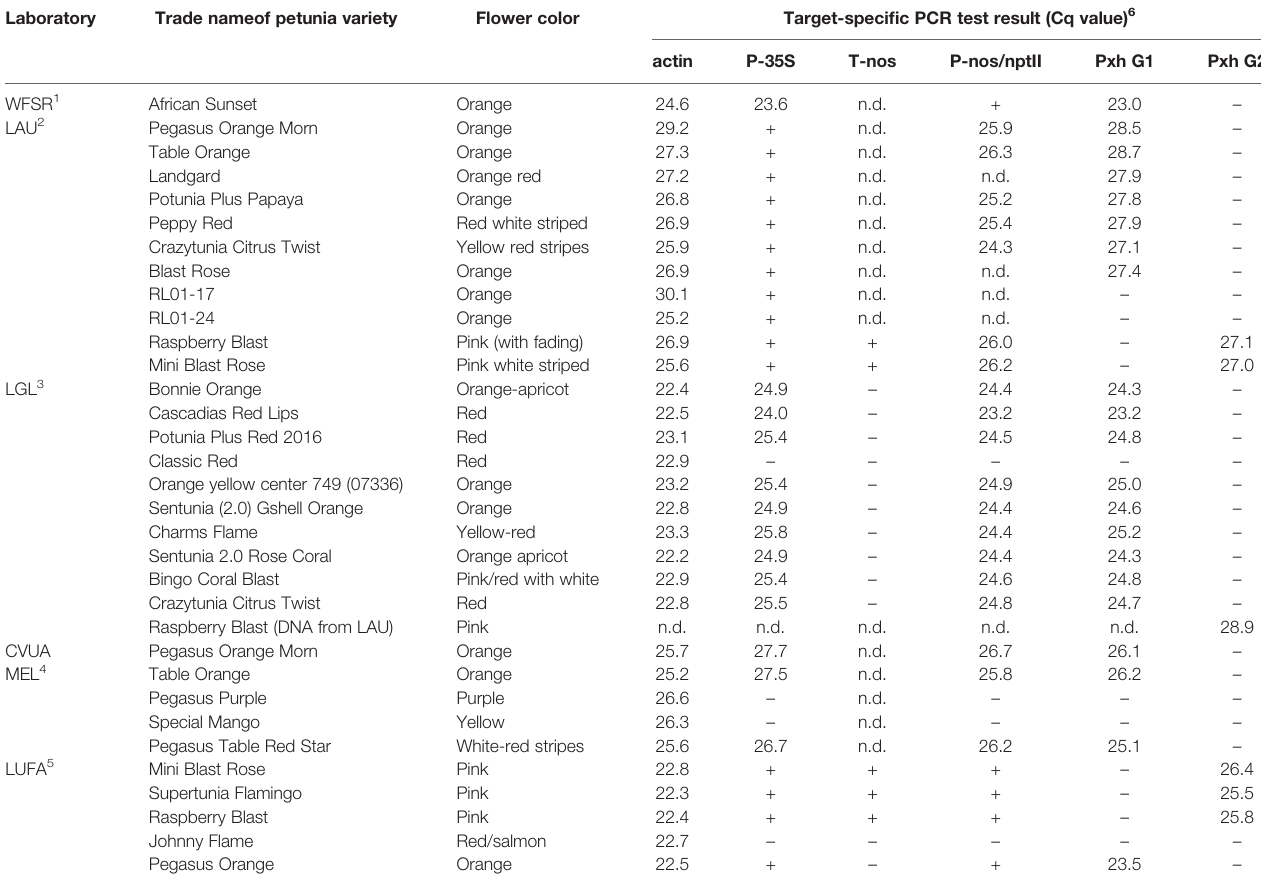
TABLE 1 | Target-speci fi c PCR test results in comparative analyses of genomic DNAs extracted from different petunia varieties. Laboratory